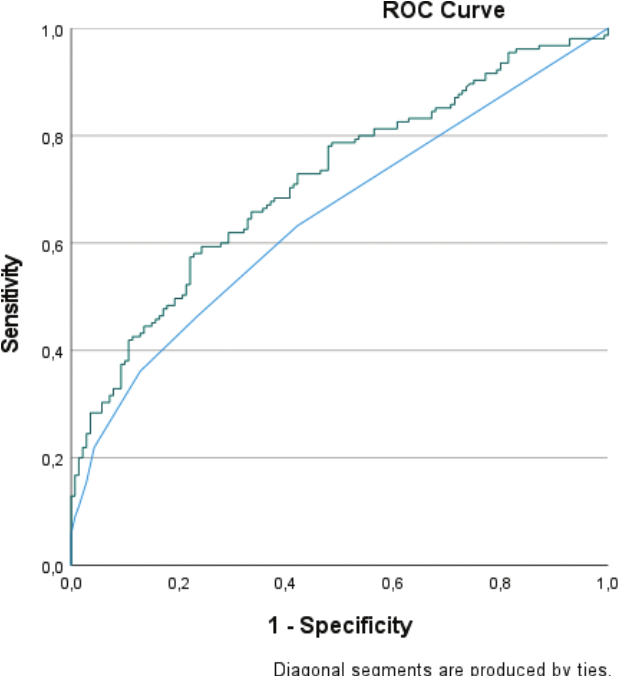
Figure 1. ROC curve for prediction of admission to a ward. Blue = NEWS. Green = NEWS +